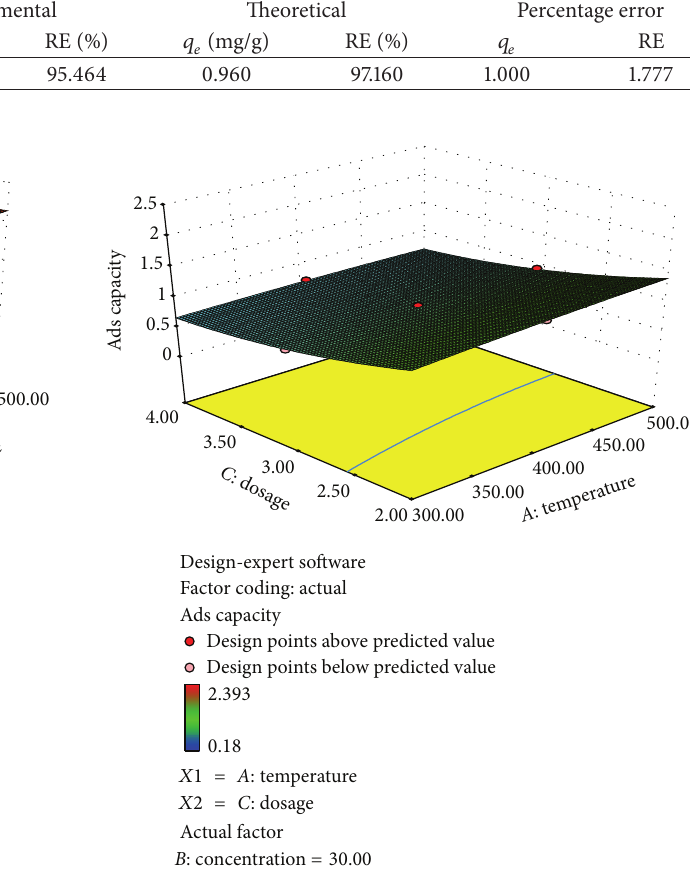
Figure 7: Combined effect of factors 𝐵 - 𝐶 on response 𝑌 1 .